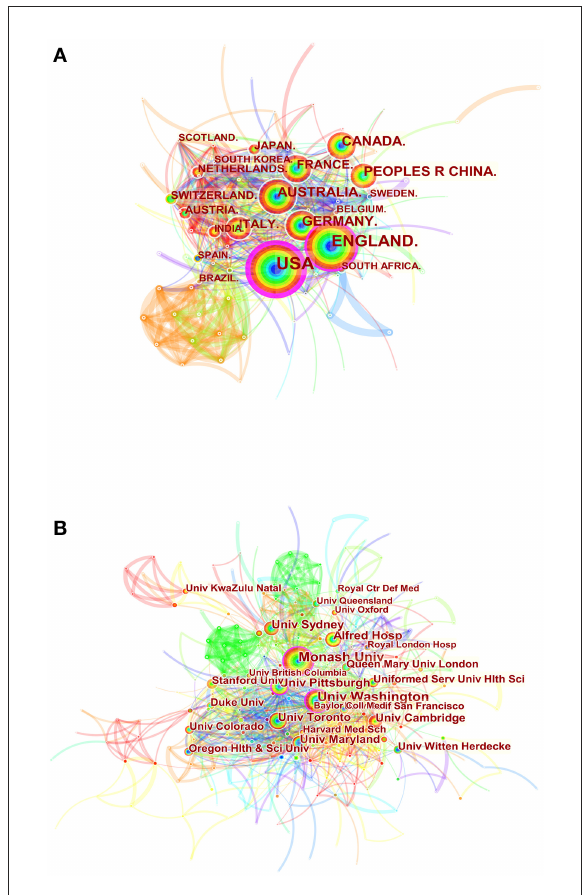
FIGURE3 Spatial distribution map of countries/regions (A) and institutions (B) . Each circle in the diagram represents a nation/institution, with the size of the circle indicating the country/institution’s publishing output. The lines that connect the circles represent international collaboration, and the broader the lines, the stronger the cooperation. The colors of the node and line represent different years, and the warmer the color, the more recent the time of